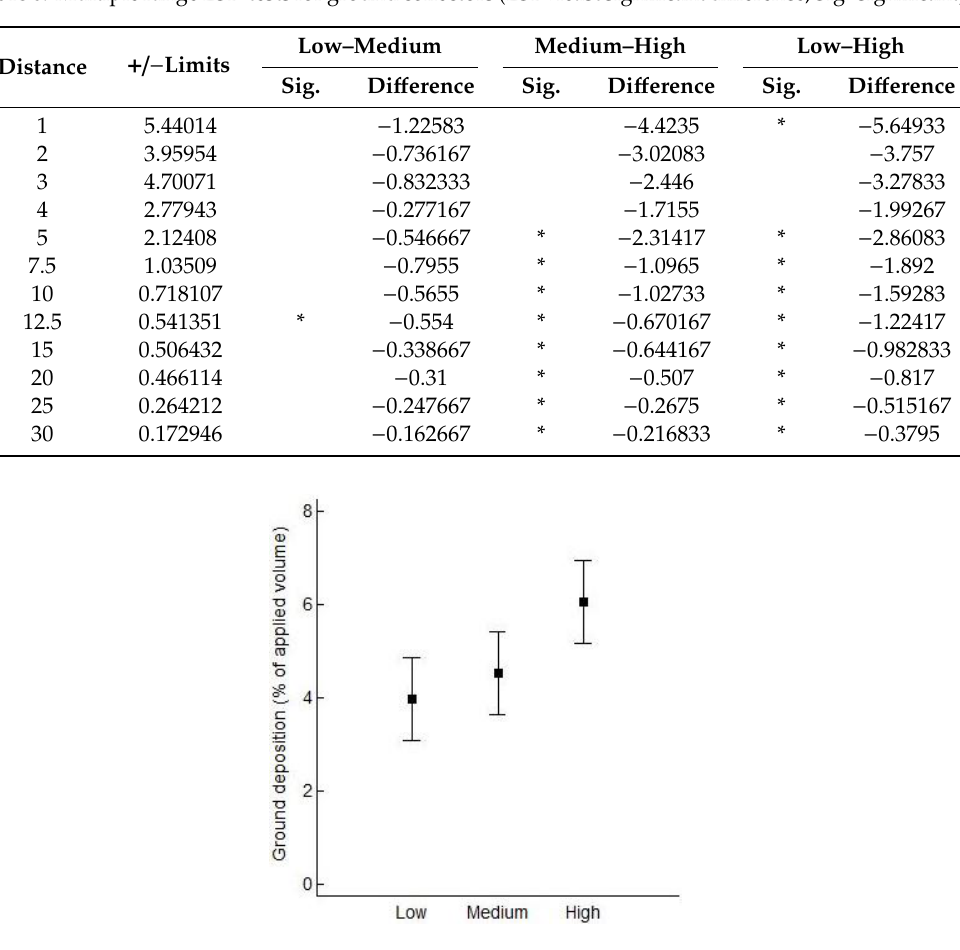
Table 7. Airborne spray drift deposition. Distance m